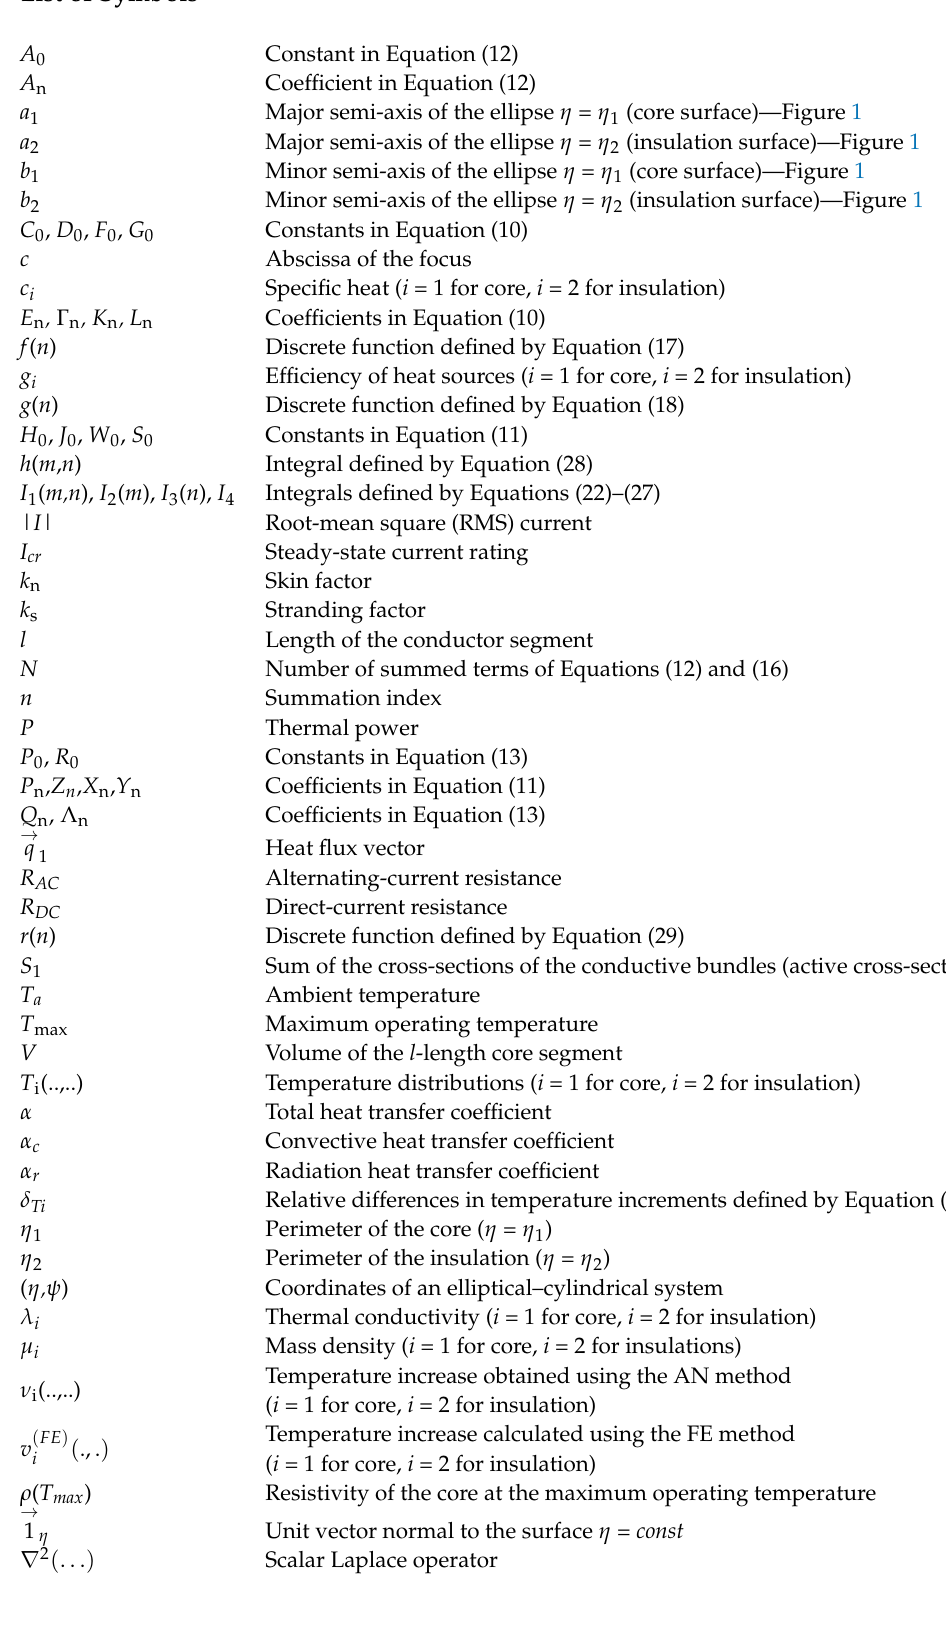
Major semi-axis of the ellipse η = η 1 (core surface)—Figure 1 Major semi-axis of the ellipse η = η 2 (insulation surface)—Figure 1 Minor semi-axis of the ellipse η = η 1 (core surface)—Figure 1 Minor semi-axis of the ellipse η = η 2 (insulation surface)—Figure